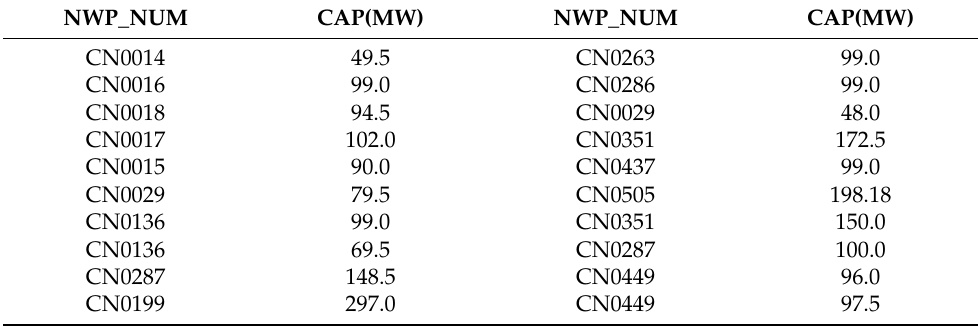
Table 4. Installed capacities of the 20 wind farms.